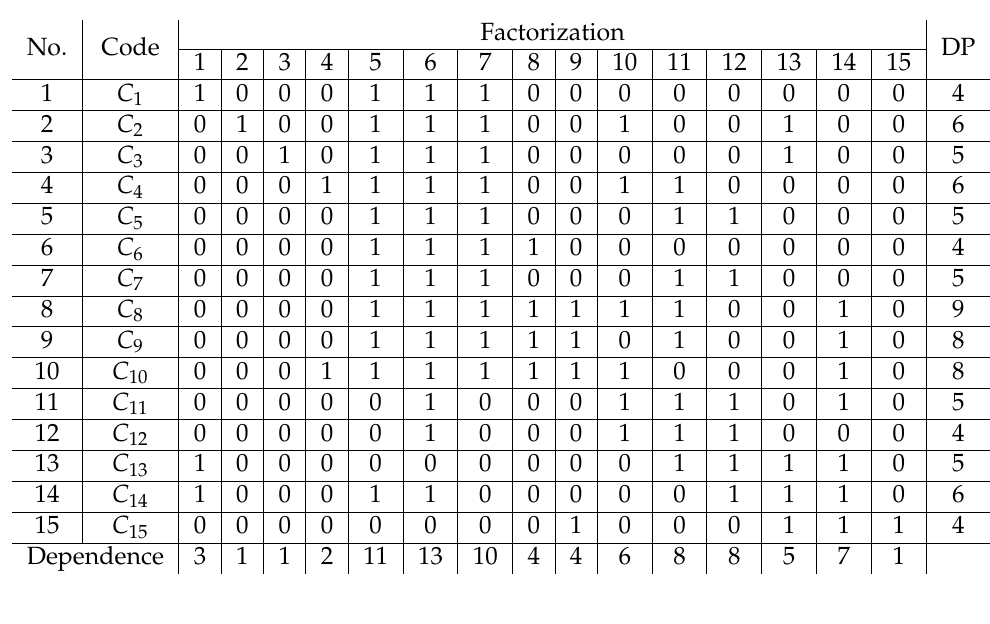
Table 6. Results of the reachability